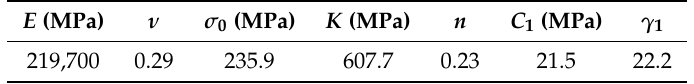
Table 2. Material parameters identified from tensile tests for E220BH